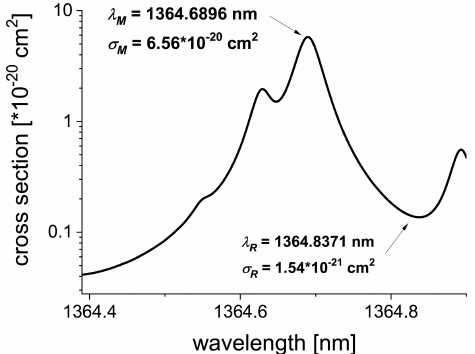
Figure 2. Absorption spectrum of the H 2 O molecule in the wave- length range relevant for the current study obtained using the HI- TRAN database ( p = 1000hPa, T = 23 ◦ C, n = 10 16 cm − 3 ). The marked extrema are the wavelengths selected for laser